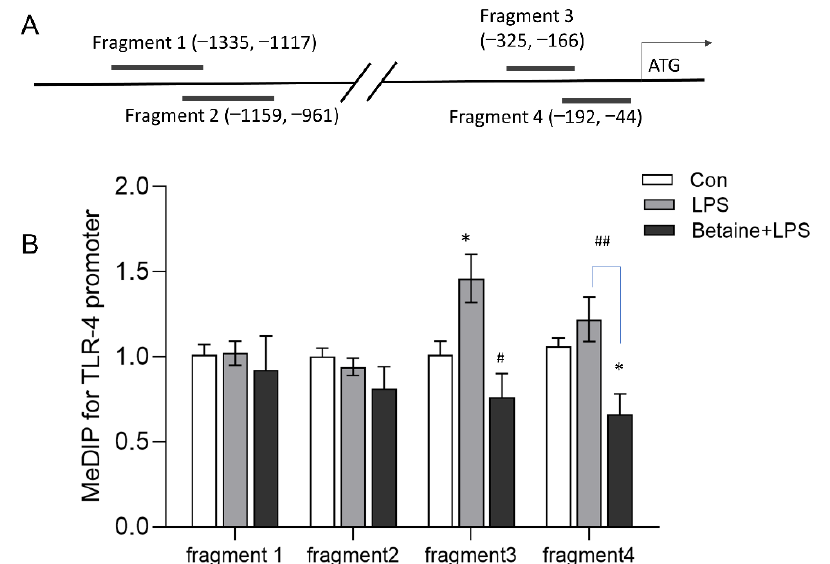
Figure 5. Schematic structure of the chicken TLR4 gene promoter and the methylation status. ( A ) The schematic structure of the chicken TLR4 promoter. Fragments 1-4 were regions detected by MeDIP-PCR. ( B ) The methylation levels of fragments 1–4. Values are mean ± SEM, n = 4/group. Significance levels: * p < 0.05 vs. control, # p < 0.05, ## p < 0.01 vs. LPS.